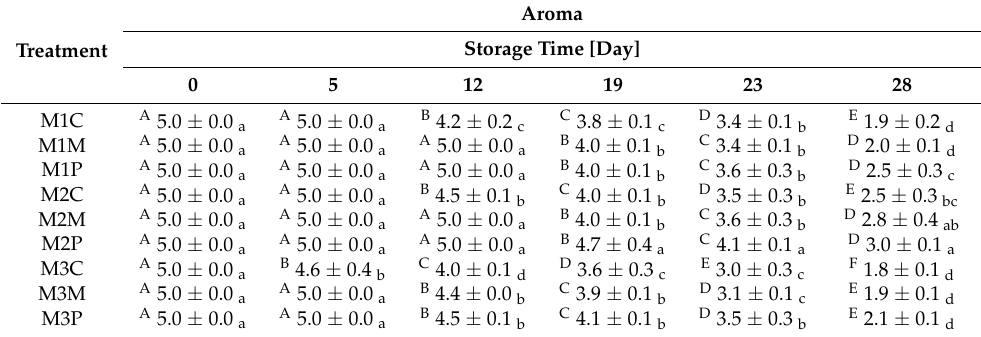
Table 4. Effect of lysozyme and modified atmosphere on aroma of pork meat stored at 4 ◦ C ± 1 ◦ C.